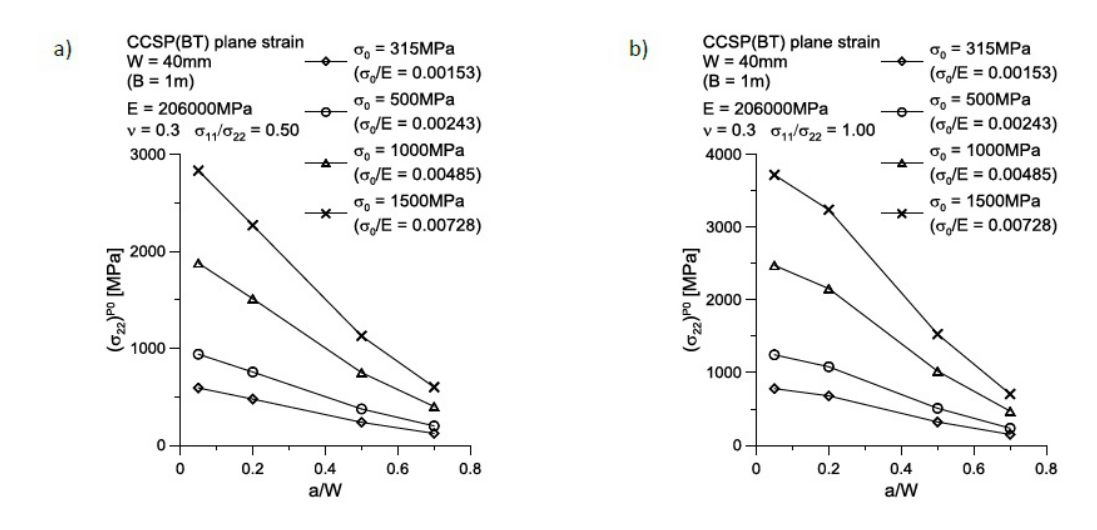
Figure 8: Limit load ( σ 22 ) P 0 vs. crack length for the plane stress state.